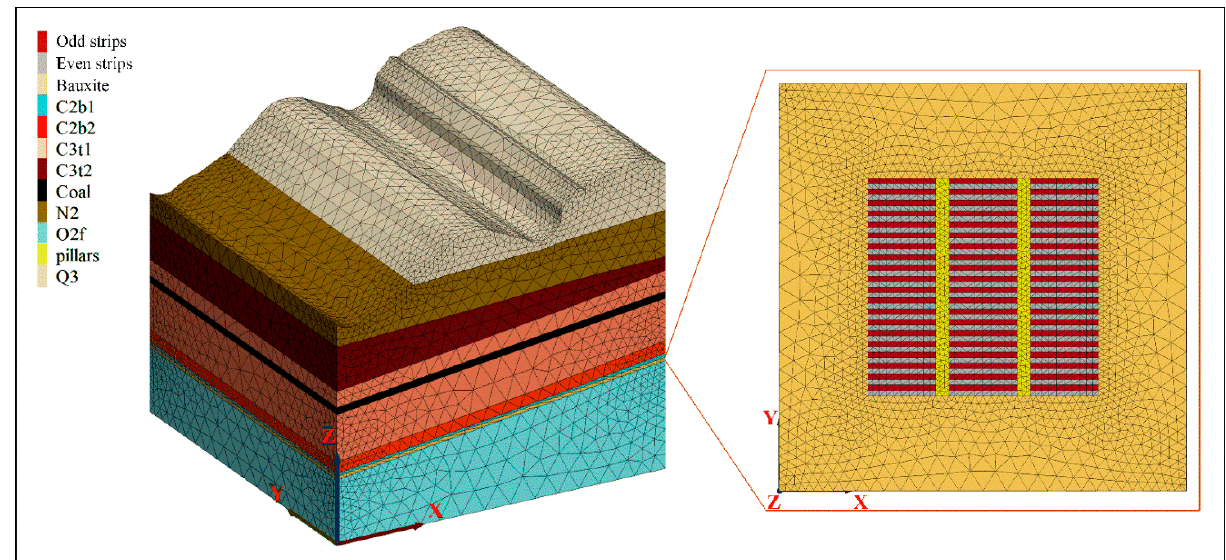
Figure 5. Numerical analysis model of BCS.